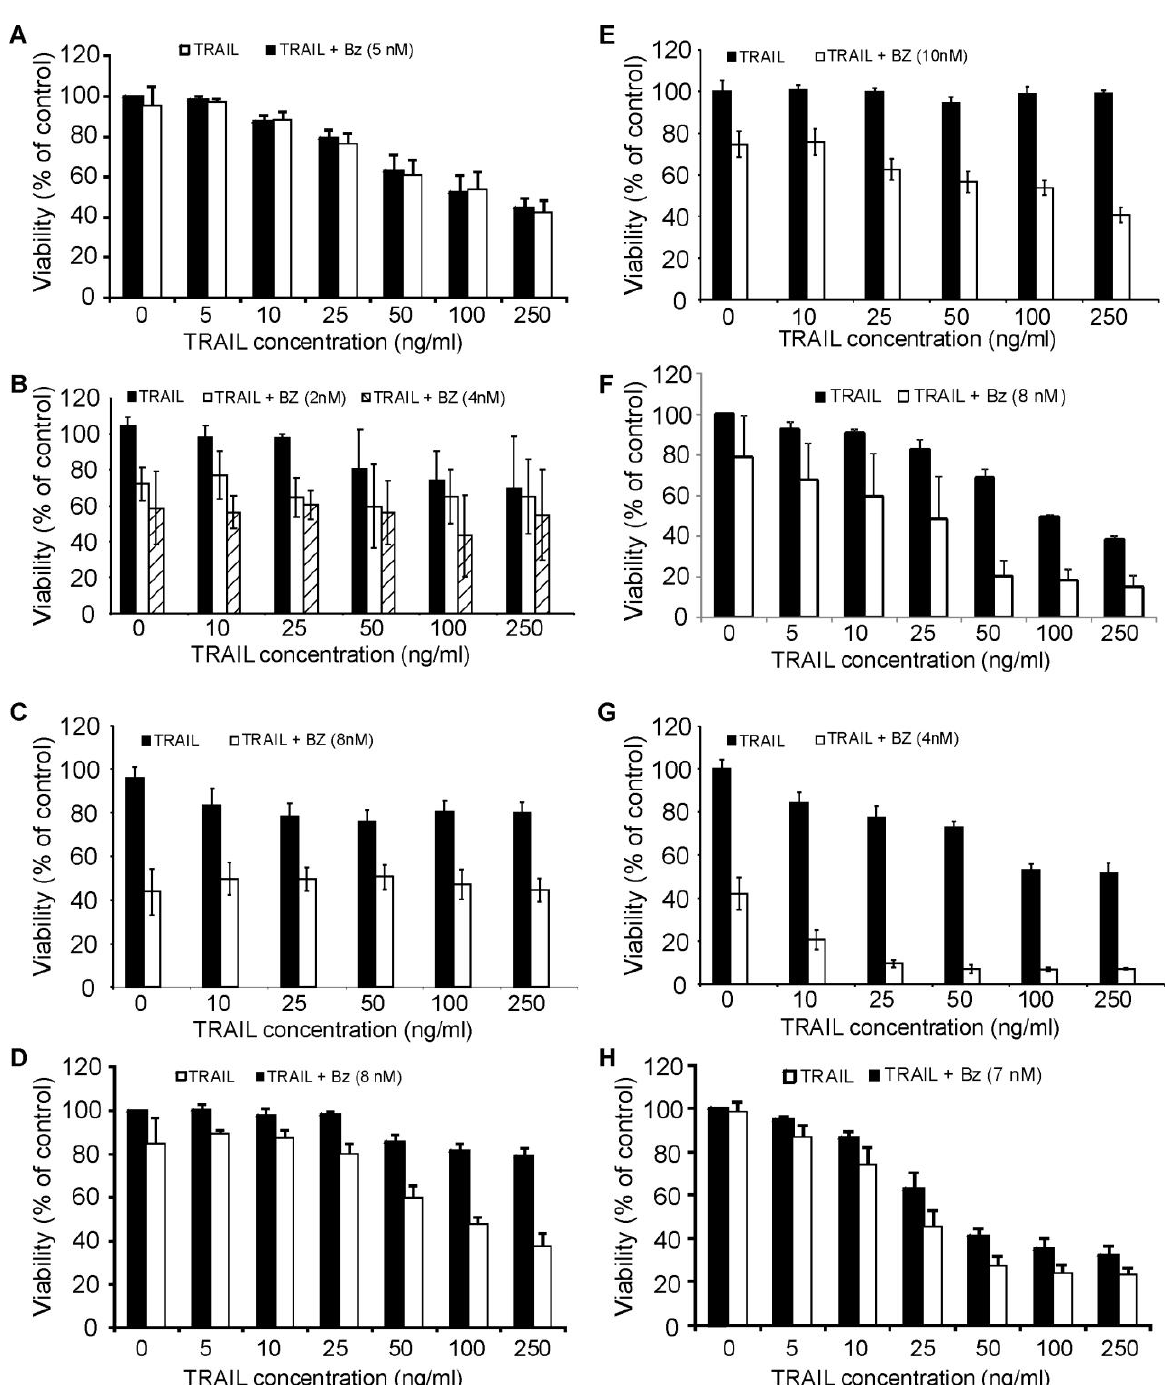
Figure 5. Bortezomib sensitizes ML-1, ML-2, OCI AML2, OCI AML3 and MOLM13 to TRAIL induced apoptosis. AML cells were pre-treated with a sublethal dose of bortezomib that induced 20% cell death (2 nM (KG-1), 4 nM (KG-1, ML-2), 5 nM (HL-60), 7 nM (ML-1), 8 nM (Kasumi, OCI AML2, MOLM13) or 10 nM (OCI AML3)) for 18 h followed by a 18 h (KG-1, Kasumi, OCI AML3, ML-2) or 24 h (HL-60, ML-1, OCI AML2, MOLM13) treatment with 5, 10, 25, 50, 100, 250, 500 or 1000 ng/mL TRAIL. Cell viability was measured by MTT assay; values are expressed as a percent of untreated cells and presented as mean ± S.E.M. ( A ) HL-60; ( B ) KG-1; ( C ) Kasumi; ( D ) OCI AML2; ( E ) OCI AML3; ( F ) MOLM13; ( G ) ML-2; ( H )